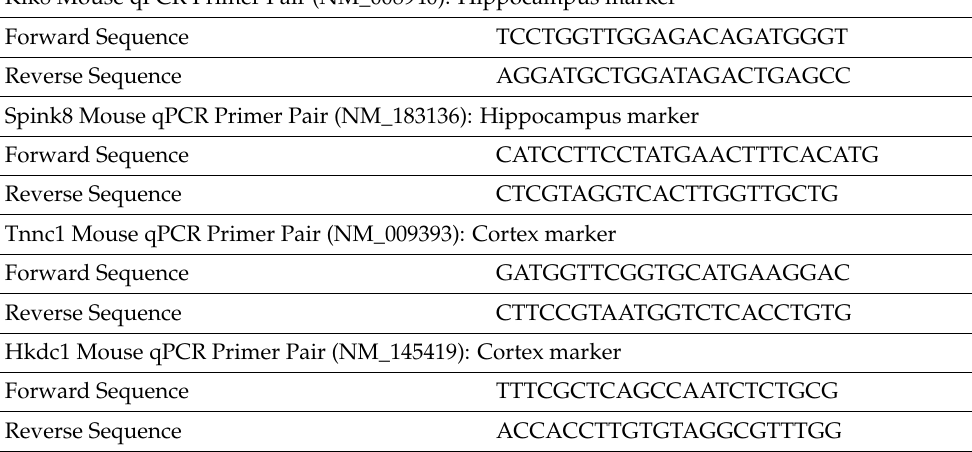
Table 1. List of primers used for the transcriptional profiling of the brain region markers through real-time